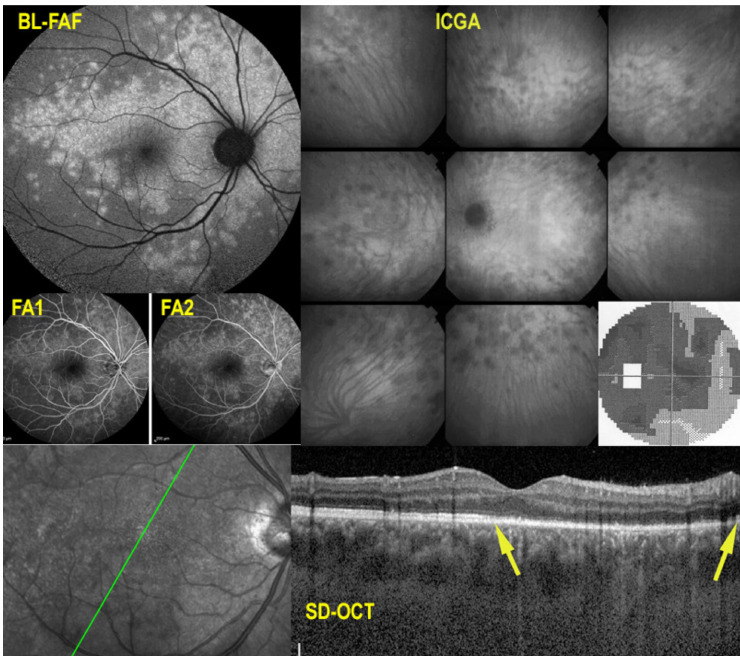
Figure 1. Multimodal imaging signs in MEWDS. BL-FAF ( top left ) showing geographic and confluent areas of hyperautofluorescence indicating active lesions. ICGA ( top right , different patient) showing patchy areas of hypofluorescence with peripapillary hypofluorescence causing severe visual field loss (insert). FA ( middle left ) faint hyperfluorescence on early (FA1) and late (FA2) frames. SD-OCT ( bottom ) showing loss of photoreceptor outer segments (between yellow arrows).